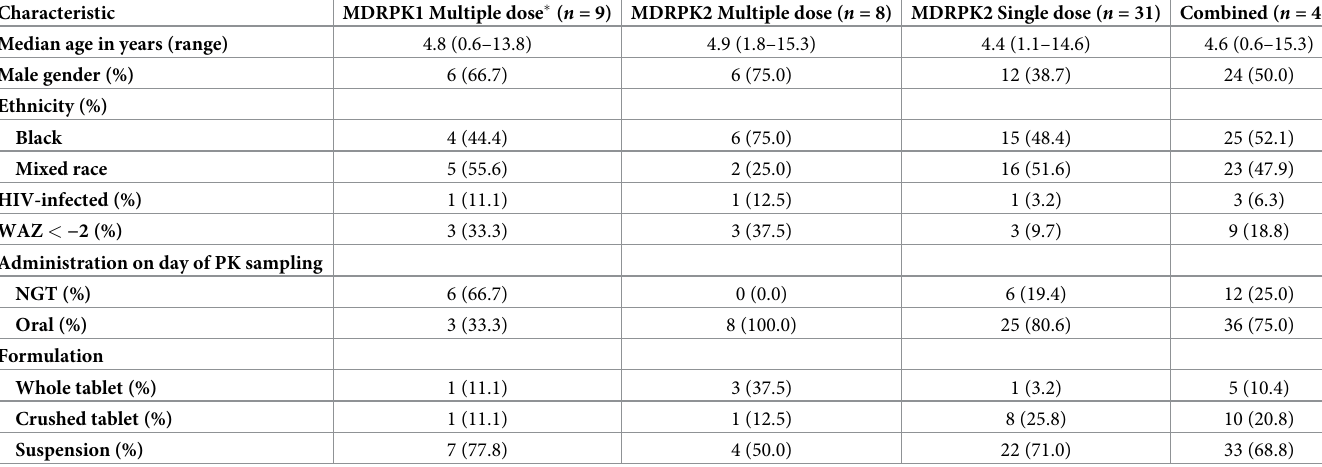
Table 1. Baseline demographic and clinical characteristics of children with MDR-TB receiving linezolid including data from 2 observational pharmacokinetic studies.